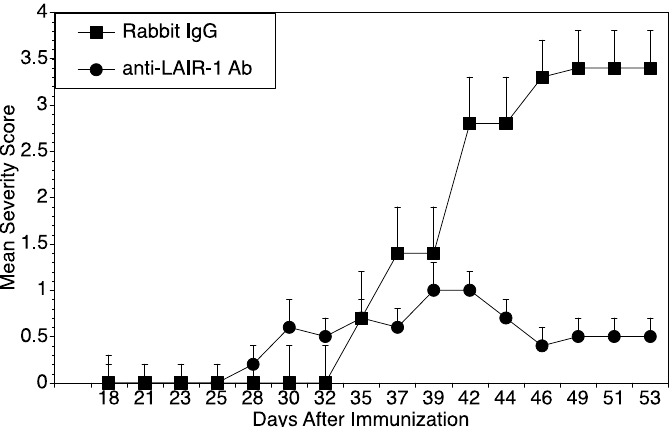
Figure 4. Treatment with Polyclonal antibody to LAIR-1. DR1 mice were immunized with CII/CFA to induce arthritis. Six mice were given intraperitoneal injections on day 0, 7, and 14 with 100 µg/dose of α -LAIR polyclonal IgG antibodies and seven mice were given 100 µg/dose of normal rabbit IgG as a control. Mice were scored for severity. The mice treated with antibody to LAIR-1 had significantly less arthritis severity than mice treated with control beginning on day 42 ( p ≤ 0.05).